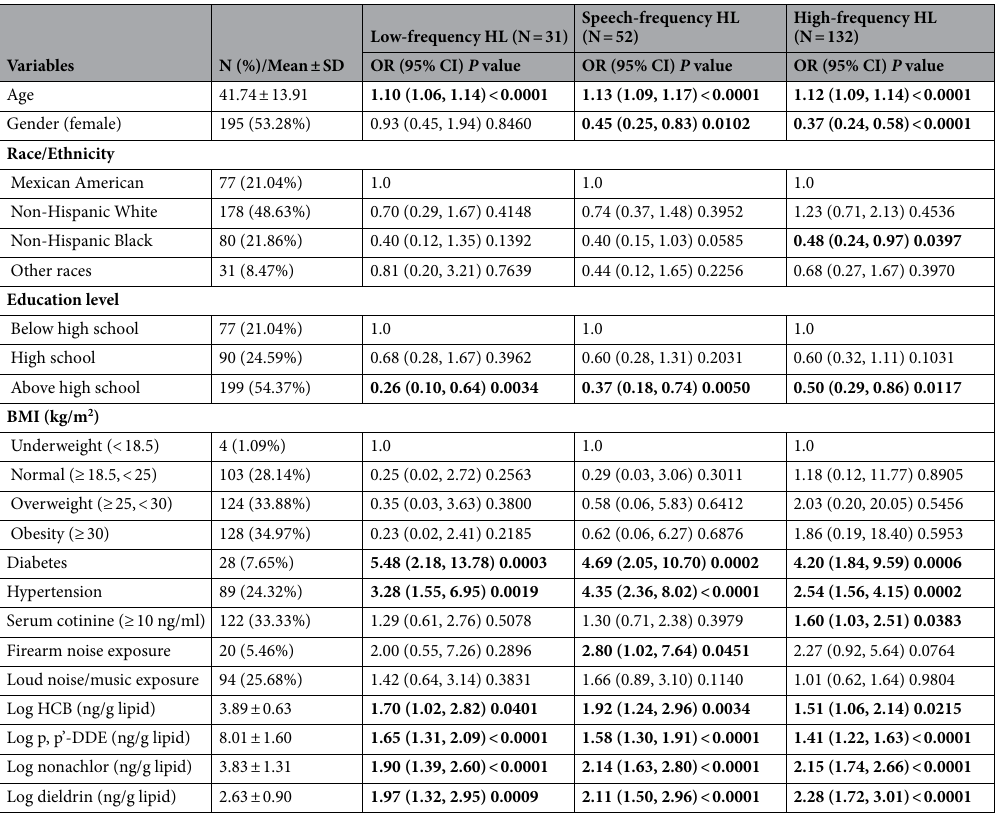
Table 2. The univariate analysis of comparison of variables in hearing loss group. SD standard deviation, HL hearing loss, OR odds ratio, CI confidence interval, BMI body mass index, HCB hexachlorobenzene, p, p’-DDE p, p’-dichlorodiphenyldichloroethylene. Significant values are in